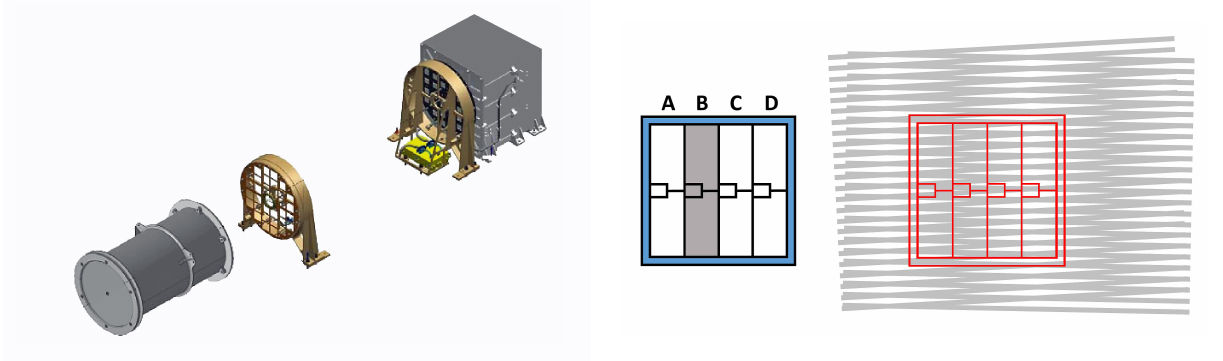
Figure 3. Left panel: the Caliste-So detector face with marked 8 large and 4 small pixels. The pixels are grouped in stripes A,B,C,D. Right panel: Moiré pattern from tilted pair of grids with overplotted detector